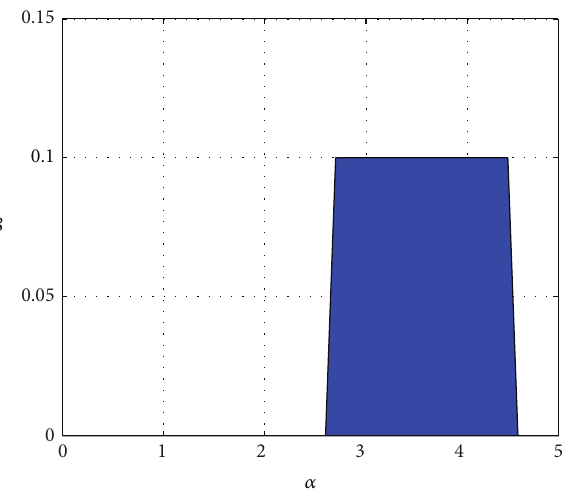
Figure 1: A region by 𝛼 and 𝛽 .